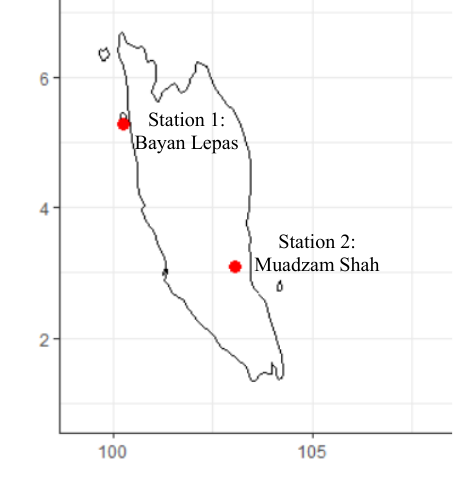
Fig. 2. The map location for 2 stations.